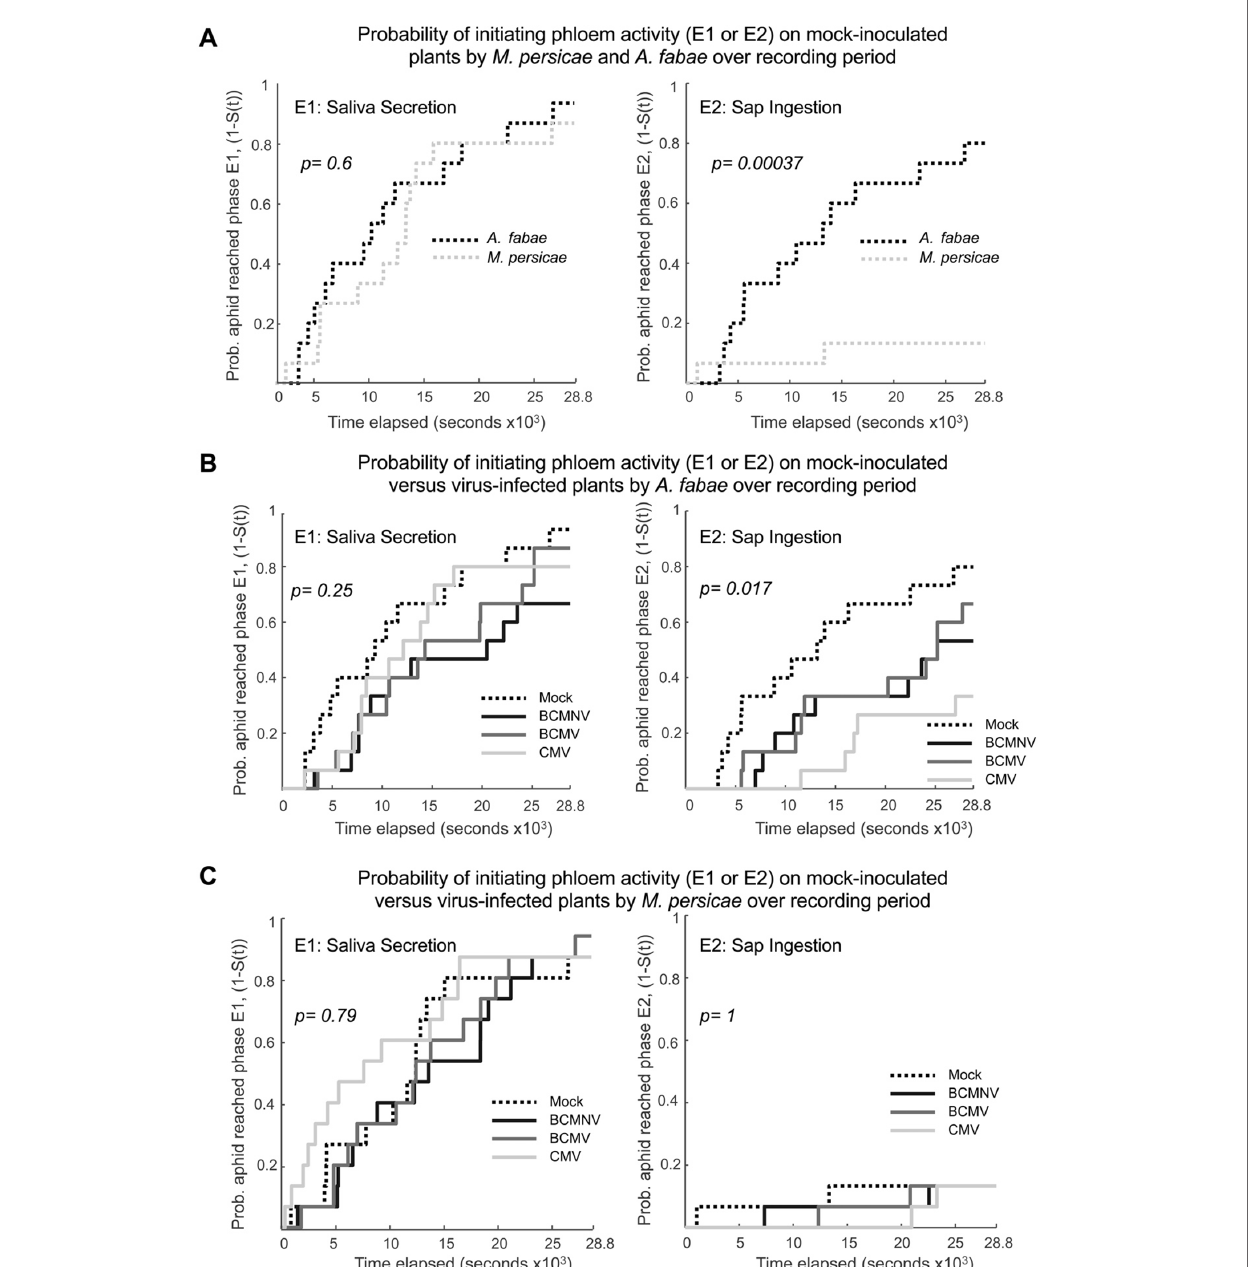
FIGURE 5 | The rate at which Aphis fabae engage in repeated phloem sap ingestion is decreased on virus-infected plants, whereas Myzus persicae is reluctant to ingest phloem sap regardless of plant infection status. The EPG E1 (saliva secretion into the phloem) and E2 (ingestion of phloem sap) waveform data for both A. fabae and M. persicae were subjected to survival analysis, which is an application of an actuarial method for assessing the probability that a speci fi c event will occur during a given period of observation time. Curves representing the probability that aphids had re-entered the phloem and were producing waveforms related to phloem feeding (i.e., survival curves, the probability that the aphid did not feed as a function of time, S(t), denoted as 1-S(t) on the Y-axes) were computed for each waveform. (A) . On mock-inoculated plants, the likelihood of aphids initiating saliva secretion (E1 activity, left panel) was similar for the legume specialist A. fabae and for the generalist M. persicae . However, the probability of transitioning back to phloem sap ingestion (E2 activity, right panel) was signi fi cantly lower for M. persicae than for A. fabae . When feeding on virus-infected plants (infected with either BCMV, BCMNV, or CMV), there was no signi fi cant decrease in the probability of either A. fabae (B) or M. persicae (C) initiating saliva secretion into the phloem (E1 activity, left panels). However, A. fabae was signi fi cantly less likely to initiate phloem sap ingestion (E2 activity, right panel of B ) on virus-infected plants than on mock-inoculated plants. The infection status of plants made no signi fi cant difference to the already very low probability with which M. persicae re-initiates phloem sap ingestion (E2 activity, right panel of B ). The survivorship functions, S(t), were calculated as Kaplan-Meier estimates and Kaplan-Meier p-values are shown (see Supplementary Information Excel File 3 for pairwise curve